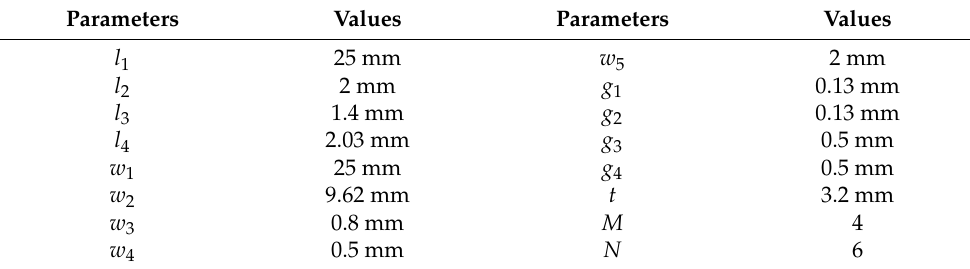
Figure 1. Geometry of the proposed printed antenna: ( a ) isometric view; ( b ) top view; ( c ) bottom view; ( d ) side view. Table 1. Optimized design parameters of the proposed